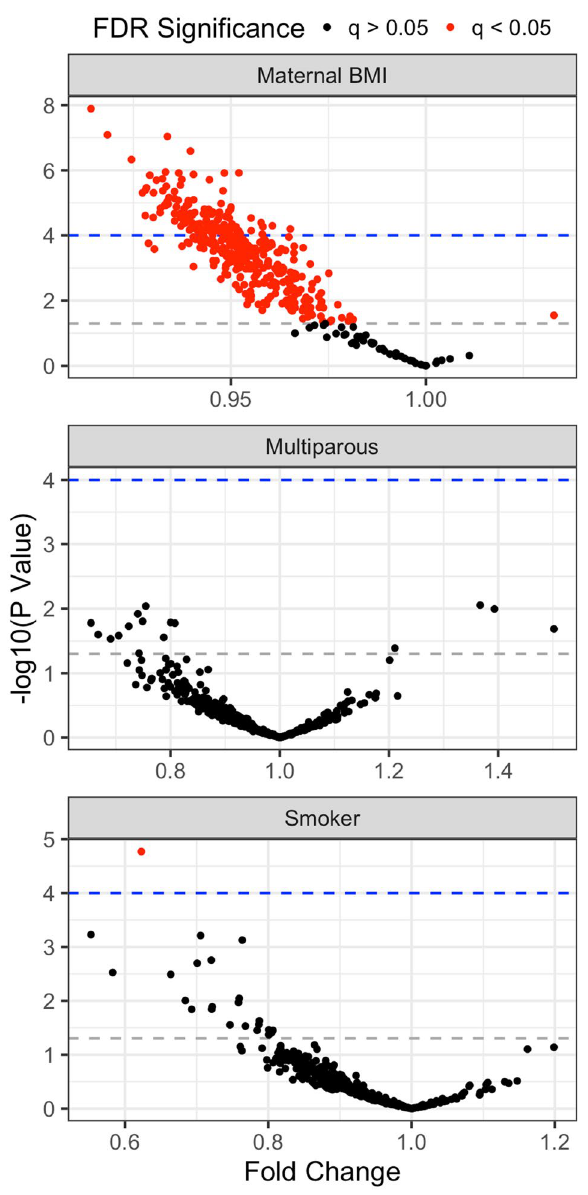
Figure 5. Volcano plots for associations between human milk EV miRNA and maternal characteristics where each point represents an effect estimate as fold change (x-axis) and − log10(p-value) (y-axis) for an individual miRNA. Effect estimates for maternal BMI (top panel) represent fold change per 1 kg/m 2 increase in BMI, for parity (middle panel) represent fold change from nulliparous to multiparous, and for smoking represent fold change from nonsmoker to smoker. Red points are significant after correction for false discovery rate (FDR). Gray dashed line represents p = 0.05 and blue dashed line represents Bonferroni significance (p = 0.0001). All models adjusted for: collection period post-delivery, maternal age, BMI, smoking, parity, RNA starting